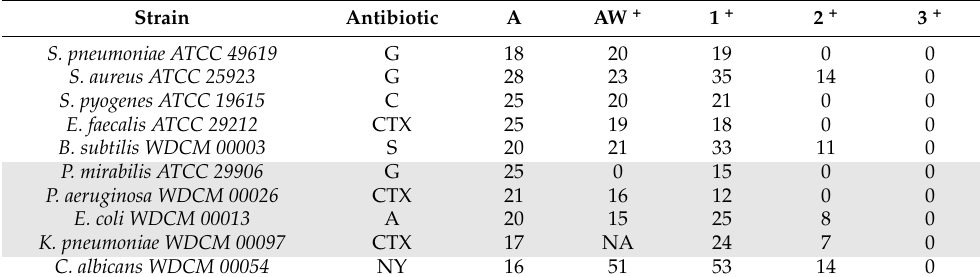
Table 4. Antimicrobial testing of antibiotics (A), [Cu(12-crown-4) 5 (H 2 O) 6 ]I 6 · 2I 2 by agar well (AW), and disc dilution studies (1,2,3). ZOI (mm) against microbial strains by diffusion assay. Strain Antibiotic A AW + 1 + 2 + 3 + S. pneumoniae ATCC 49619 G 18 20 19 0 0 S. aureus ATCC 25923 G 28 23 35 14 0 S. pyogenes ATCC 19615 C 25 20 21 0 0 E. faecalis ATCC 29212 CTX 25 19 18 0 0 B. subtilis WDCM 00003 S 20 21 33 11 0 P. mirabilis ATCC 29906 G 25 0 15 0 0 P. aeruginosa WDCM 00026 CTX 21 16 12 0 0 E. coli WDCM 00013 A 20 15 25 8 0 K. pneumoniae WDCM 00097 CTX 17 NA 24 7 0 C. albicans WDCM 00054 NY 16 51 53 14 0 + Agar well (AW) diffusion studies (20 mg crystals of [Cu(12-crown-4) 5 (H 2 O) 6 ]I 6 · 2I 2 in 6 mm diameter well) and disc diffusion studies (6 mm disc impregnated with 2 mL of 50 µ g/mL (1), 2 mL of 25 µ g/mL (2) and 2 mL of 12.5 µ g/mL (3) of [Cu(12-crown-4) 5 (H 2 O) 6 ]I 6 · 2I 2 ). A Amikacin (30 µ g/disc). G Gentamicin (30 µ g/disc). CTX (Cefotaxime) (30 µ g/disc). NY (Nystatin) (100 IU). C Chloramphenicol (10 µ g/disc). Streptomycin (10 µ g/disc). Grey shaded area represents Gram-negative bacteria. 0 = Resistant. No statistically significant differences ( p > 0.05) between row-based values through Pearson